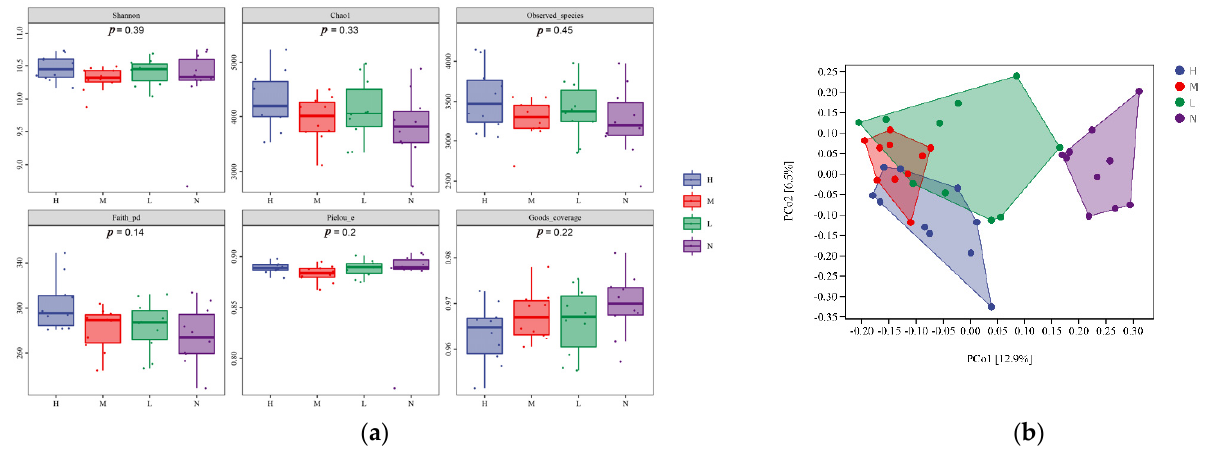
Figure 2. ( a ) Shannon index, observed species, Chao1, Pielou index of soil bacterial communities in plots with different regeneration degree; ( b ) PCoA analysis based on Bray Curtis distances of soil bacterial communities with different degrees of regeneration.